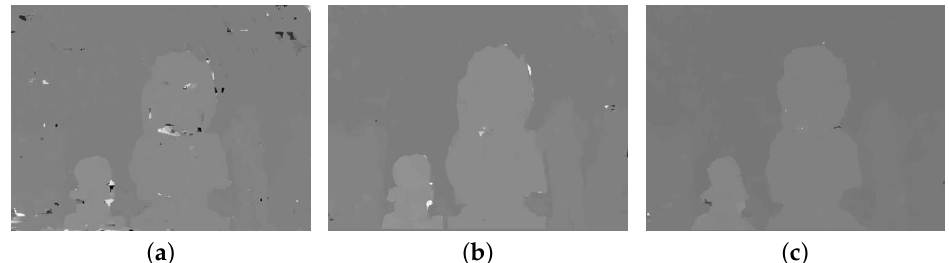
Figure 9. Disparity map comparison: ( a ) disparity generated by cross-channel normalized gradient (CCNG); ( b ) disparity generated by our method with a constant weight matrix, whose pixels value is assigned as 0.5; and ( c ) disparity generated by our method with adaptive